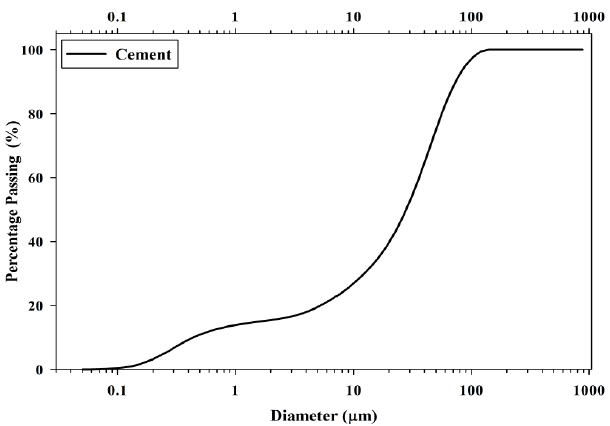
Figure 4. Particle size distribution for sand and POC fine.